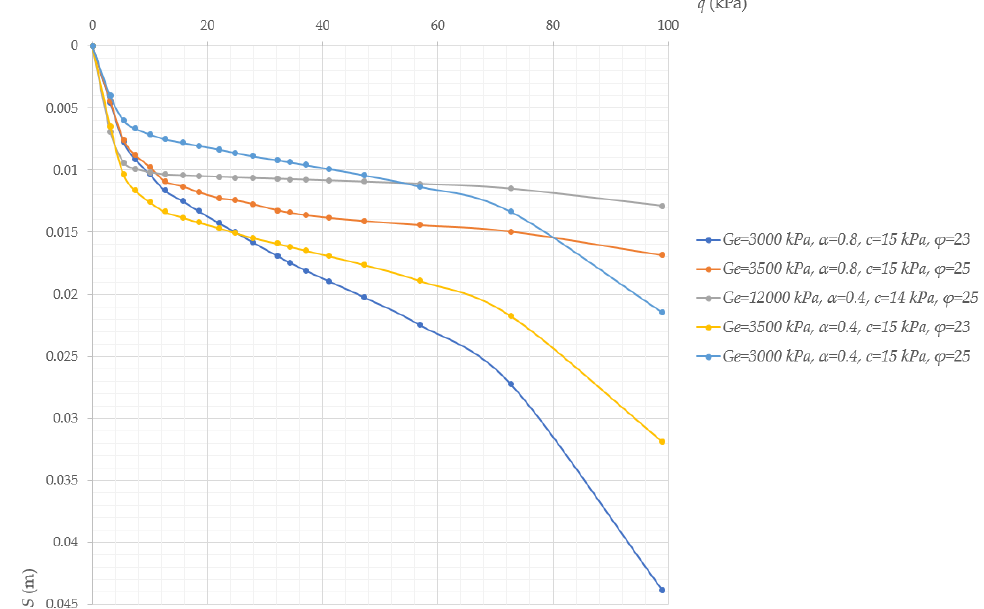
Figure 10. Dependency curves S − q with a distance d 2 = 2 m between the fence wall and the distributed load drawn using the summability method with various parameters of deformability ( G e , and α ) and strength ( φ and c ).